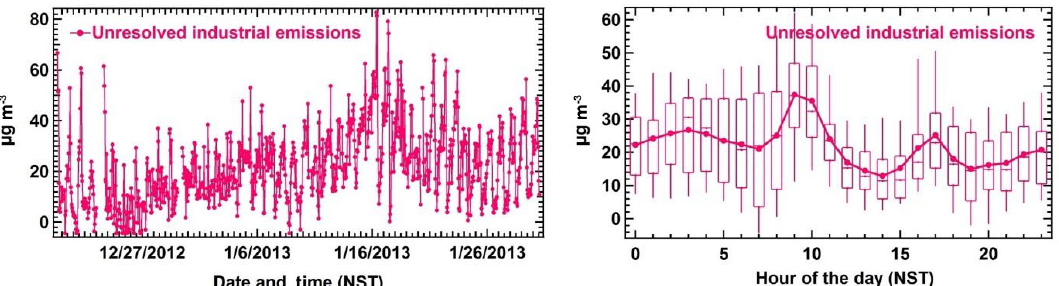
Figure 8. Time series and diel box and whisker plot for Factor 5 (unresolved industrial